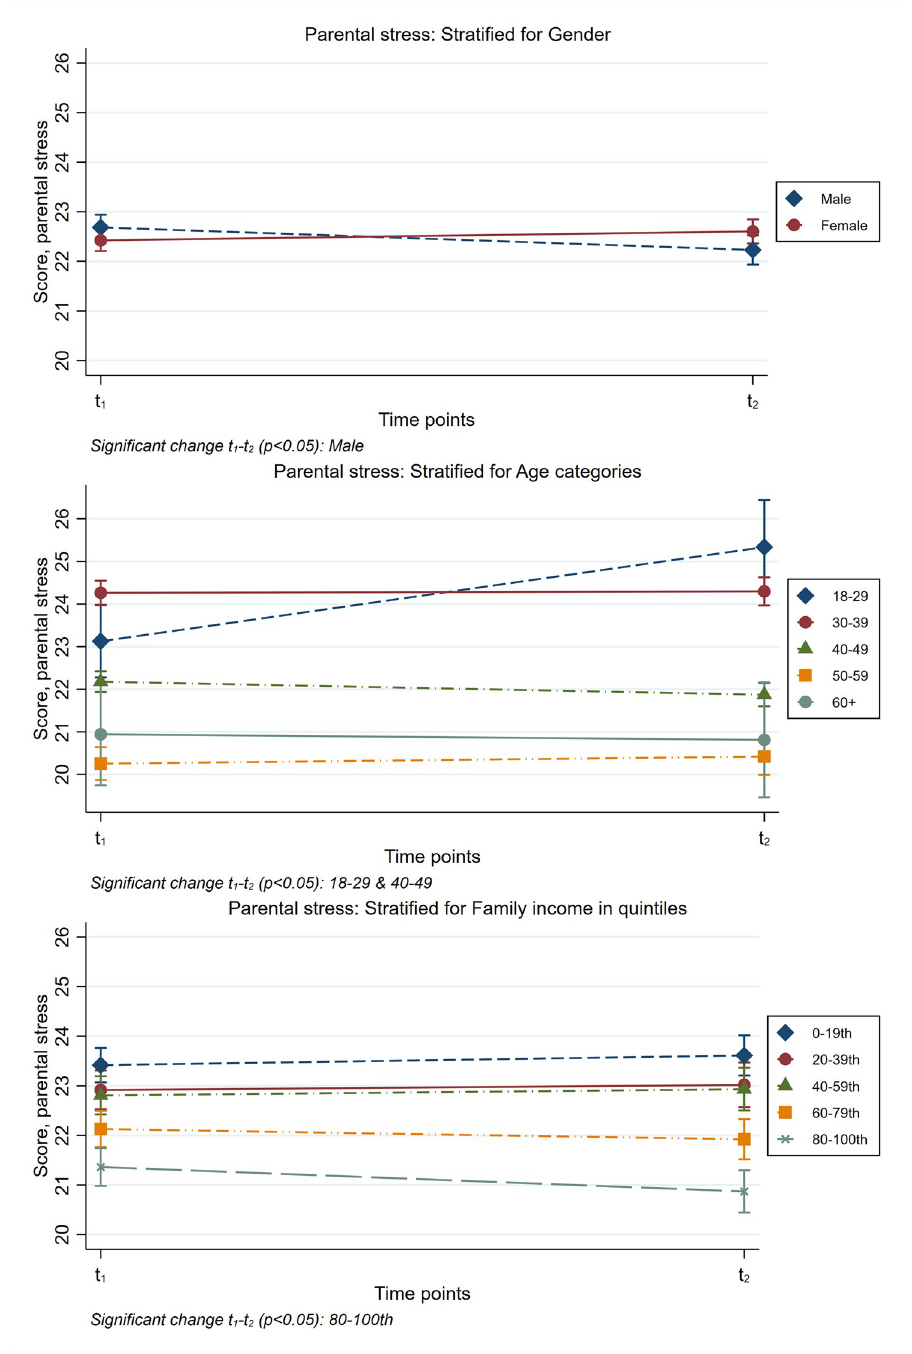
Fig 1. Stratified results for parental stressors. Time point 1 in April-May 2020. Time point 2 in April-May